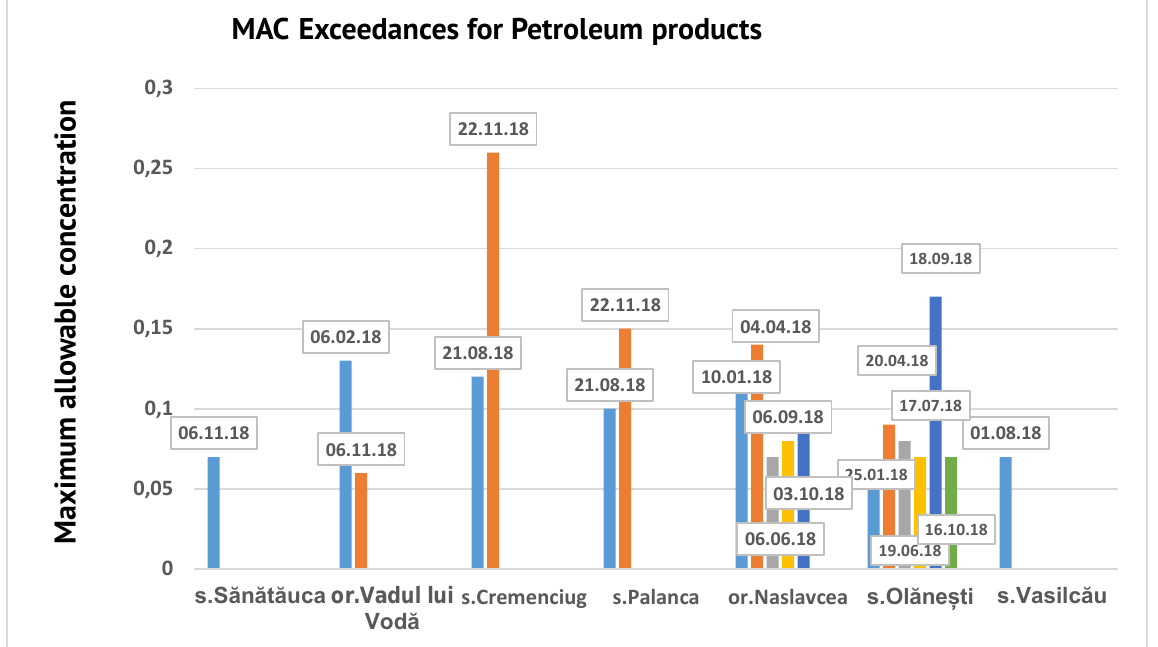
Figure 1. MAC Exceedances for Petroleum